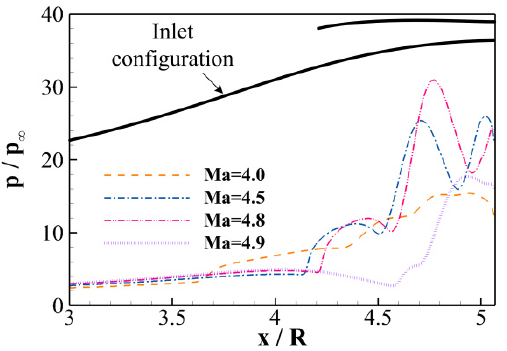
Figure 13. Wall pressure distributions during the starting process of the inlet with δ = 12°.